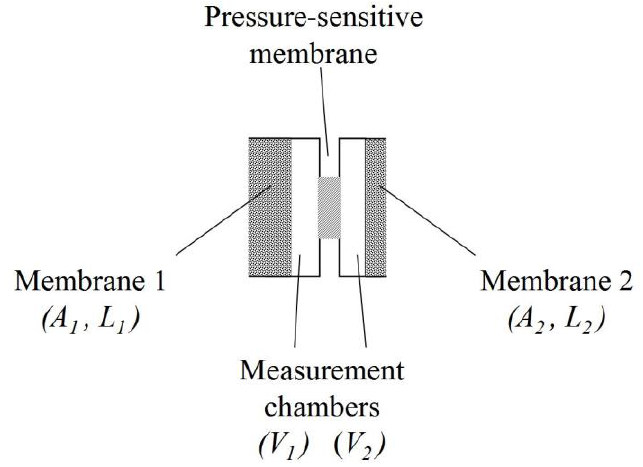
Figure 2. Combination of two cells enables a gas component to be indentified and its concentration quantified for case (II). The extension of the paired cells by an initialization unit to adjust steady-state flow condition enables use with case (I).